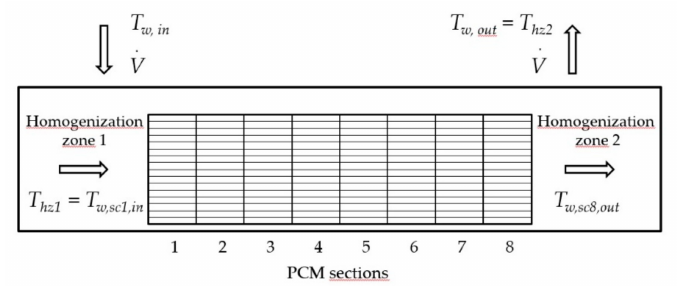
Figure 5. Distribution of the PCM storage tank as considered in the